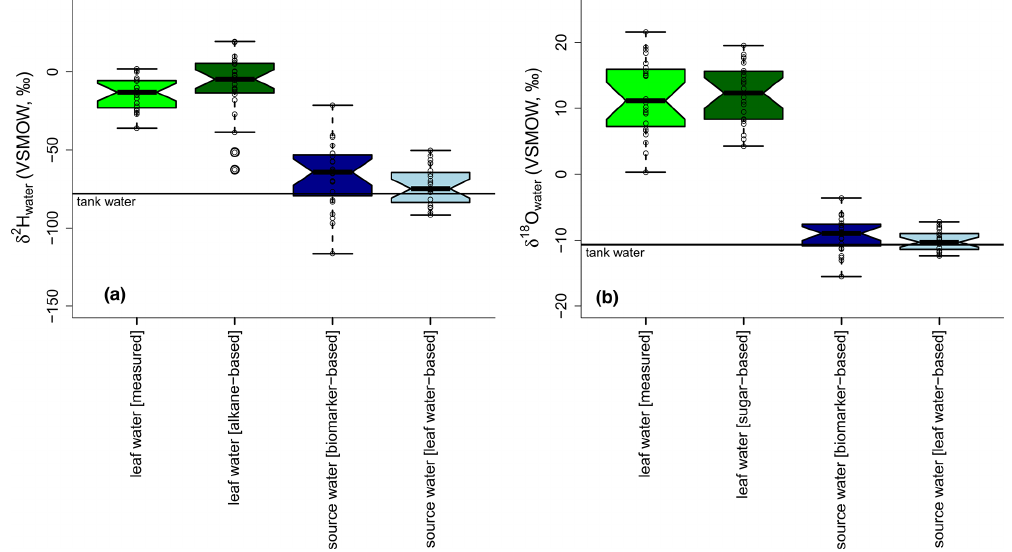
Figure 9. Boxplots showing the measured leaf water in comparison to the biomarker-based leaf water, source water calculated with biomarker-based leaf water values and source water based on measured leaf water ( a : δ 2 H leaf water ; b : δ 18 O leaf water ). Tank water is given as a solid black line in both plots. Source water isotope compositions were calculated via the slopes of the LELs (with either biomarker-based or measured leaf water values) and the GMWL. Boxplots show median (thick black line) and interquartile range (IQR) with upper (75%) and lower (25%) quartiles and lower and upper whiskers, which are restricted to 1.5 · IQR. Outside the 1.5 · IQR space, the data points are √ n by convention and give a 95% confidence interval for the difference of two marked with a dot. The notches are extended to ± 1 . 58 · IQR / medians (McGill et al.,